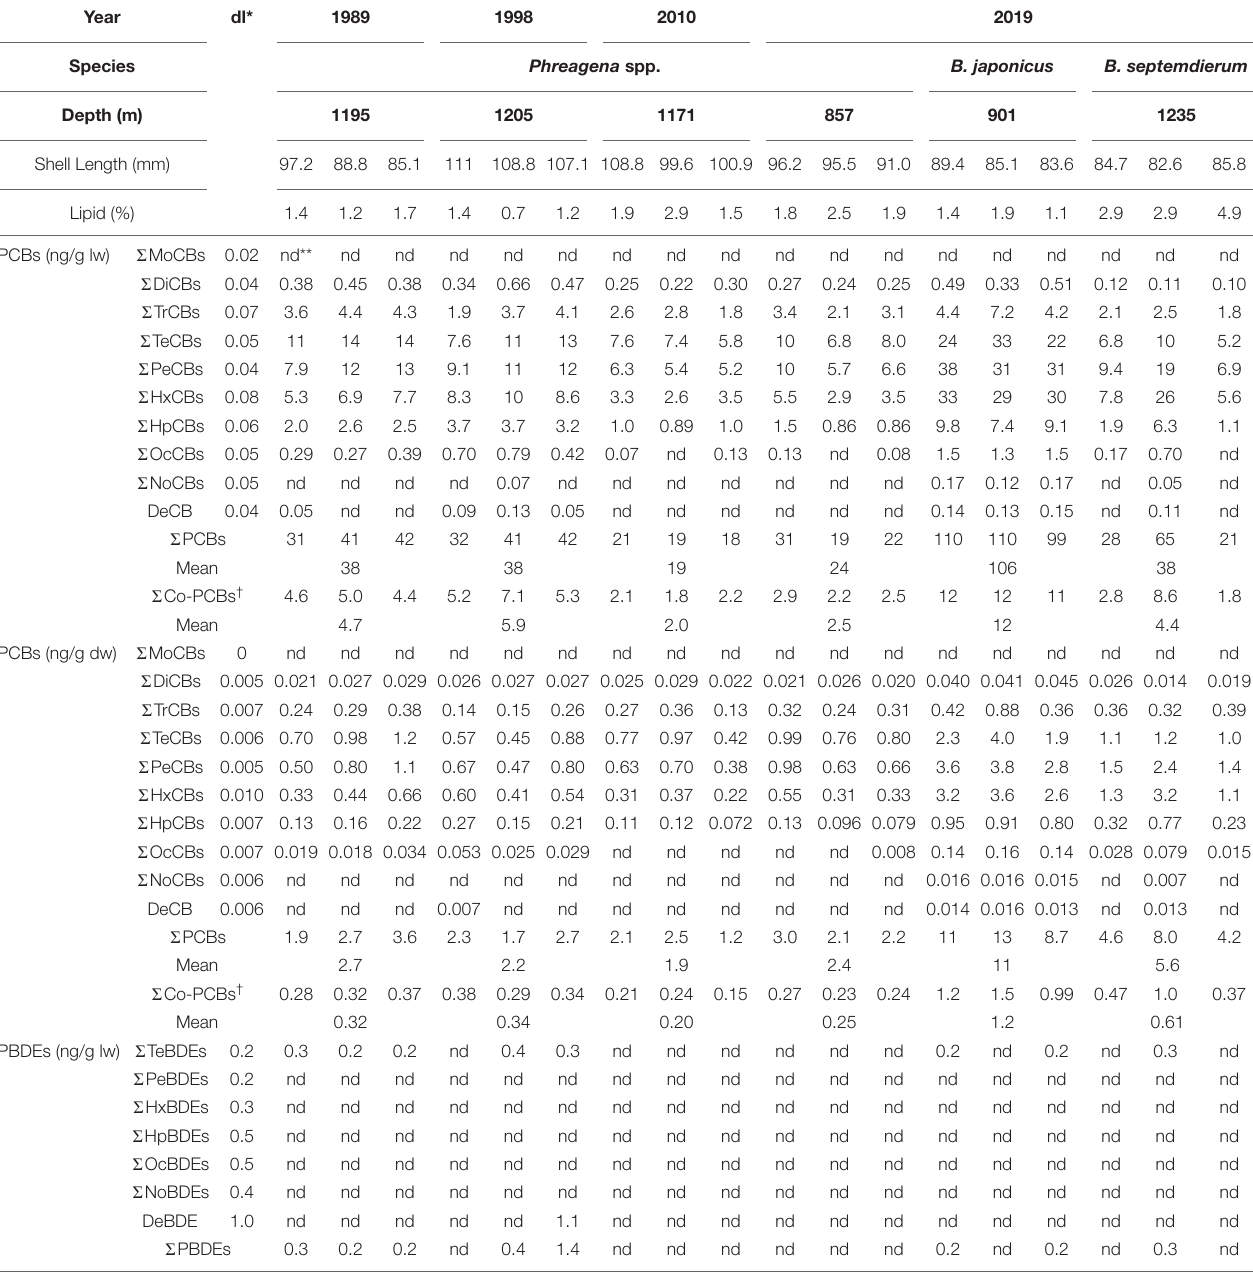
TABLE 1 | Concentrations of PCBs and PBDEs in the chemosynthetic